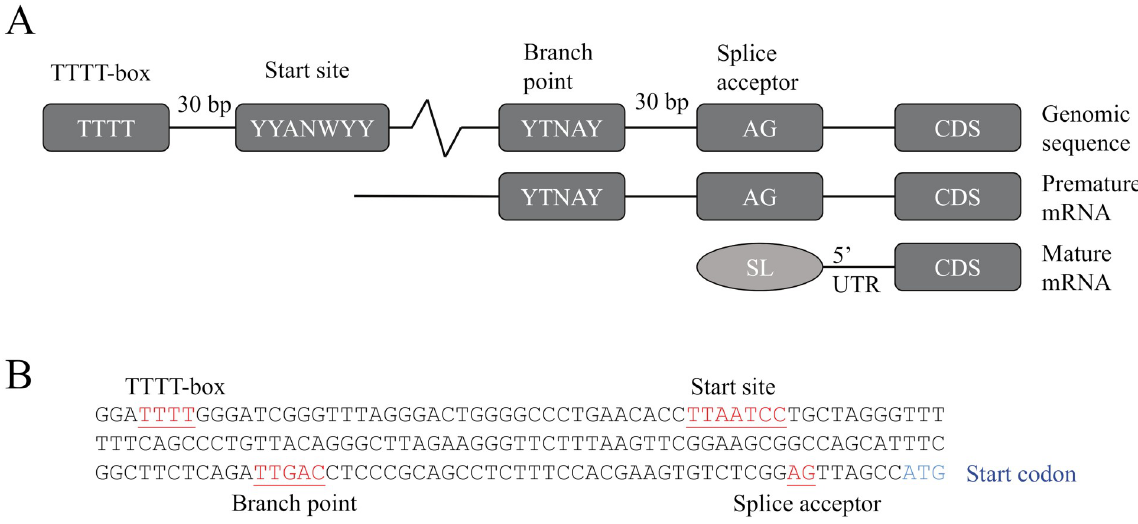
Fig 4. Unique promoter architecture in Symbiodinium . (A) A schematic view of the proposed promoter (TTTT-box) relative to the putative transcription start site, splice branch point and acceptor site, upstream of the coding region (CDS) in the genomic sequence of S . kawagutii genes. For comparison, premature mRNA and mature mRNA are also shown. Figure was adapted from Lin et al. (2015). (B) Genomic sequence of S . microadriaticum pAct promoter 175 bp upstream of the putative start codon, with promoter elements as described in (A).